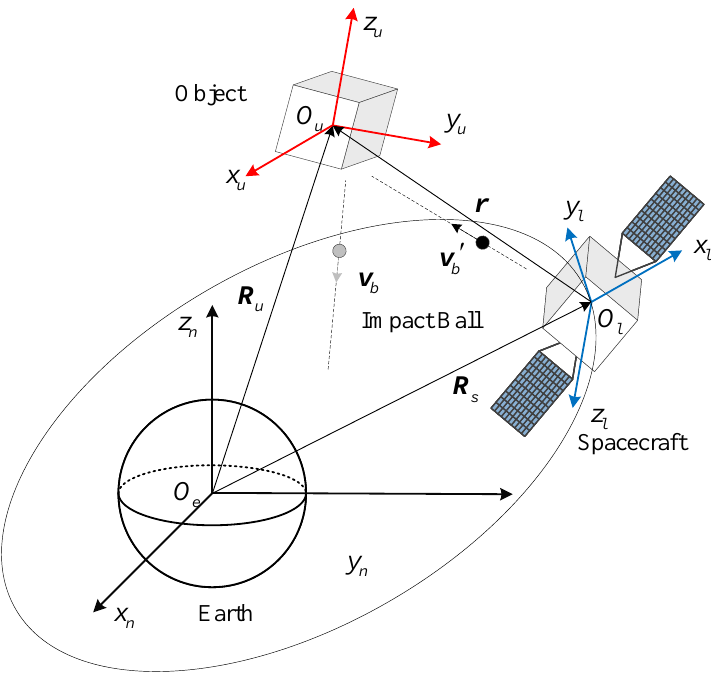
Figure 1. The schematic diagram of the collision between the object and the impact